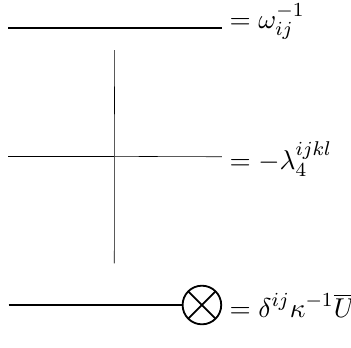
Figure 1 . Feynman rules for the statistical